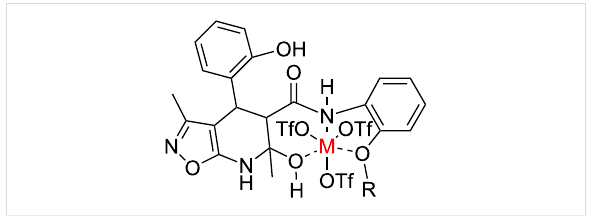
Figure 1: The possible structure of an intermediate complex in reac- tions forming the heterocycles 6